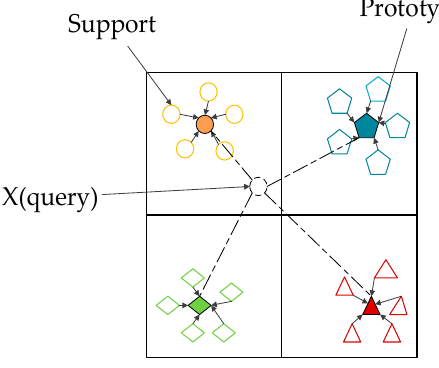
Figure 4. Prototypical layer in the 4-way 5-shot scenario.